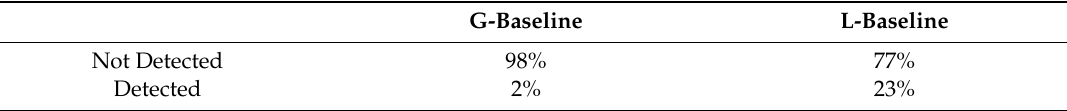
Table 8. Detection of displacement in 1D (height component).